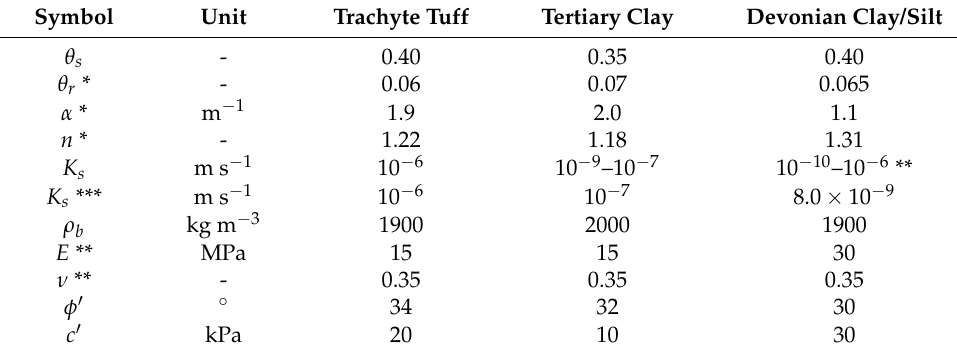
Table 2. Soil model parameters for the Dollendorfer Hardt test site.